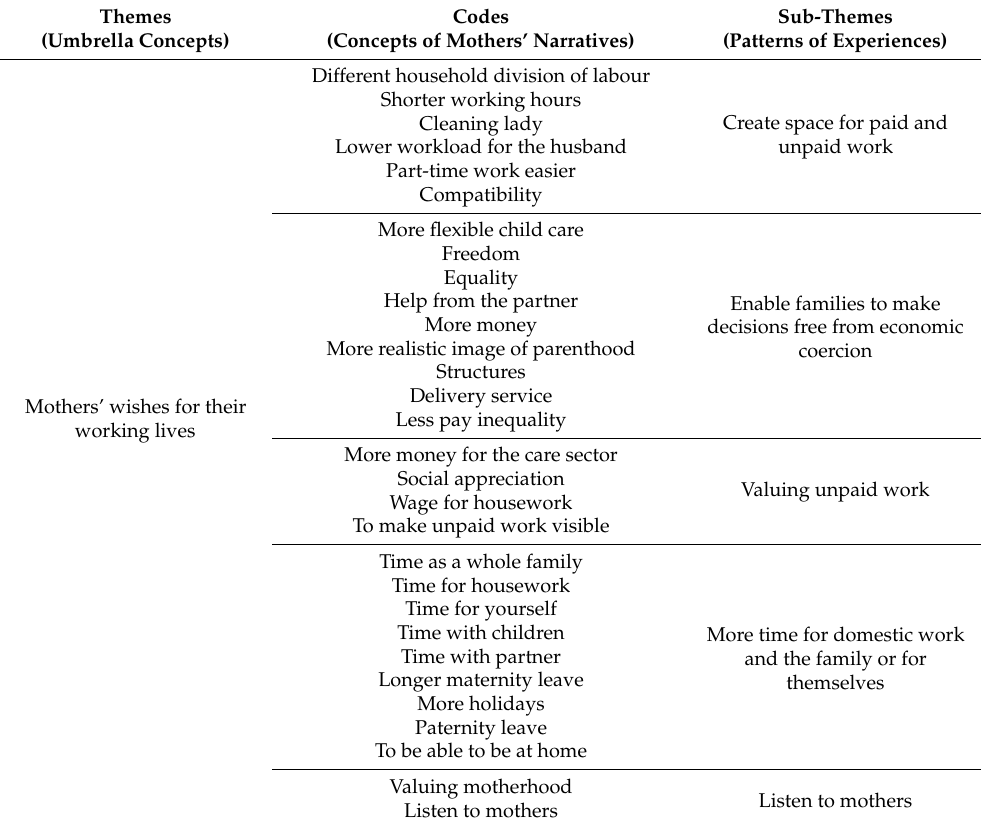
Table 1. Cont . Themes (Umbrella Concepts)